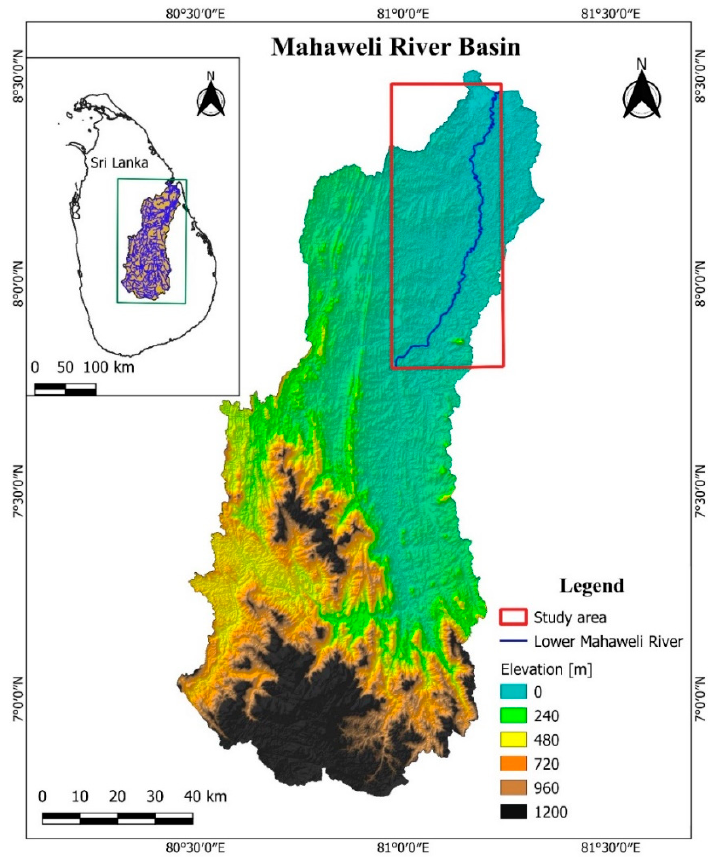
Figure 2. Map of the Mahaweli River basin, Sri Lanka and the selected river segment for the analysis.